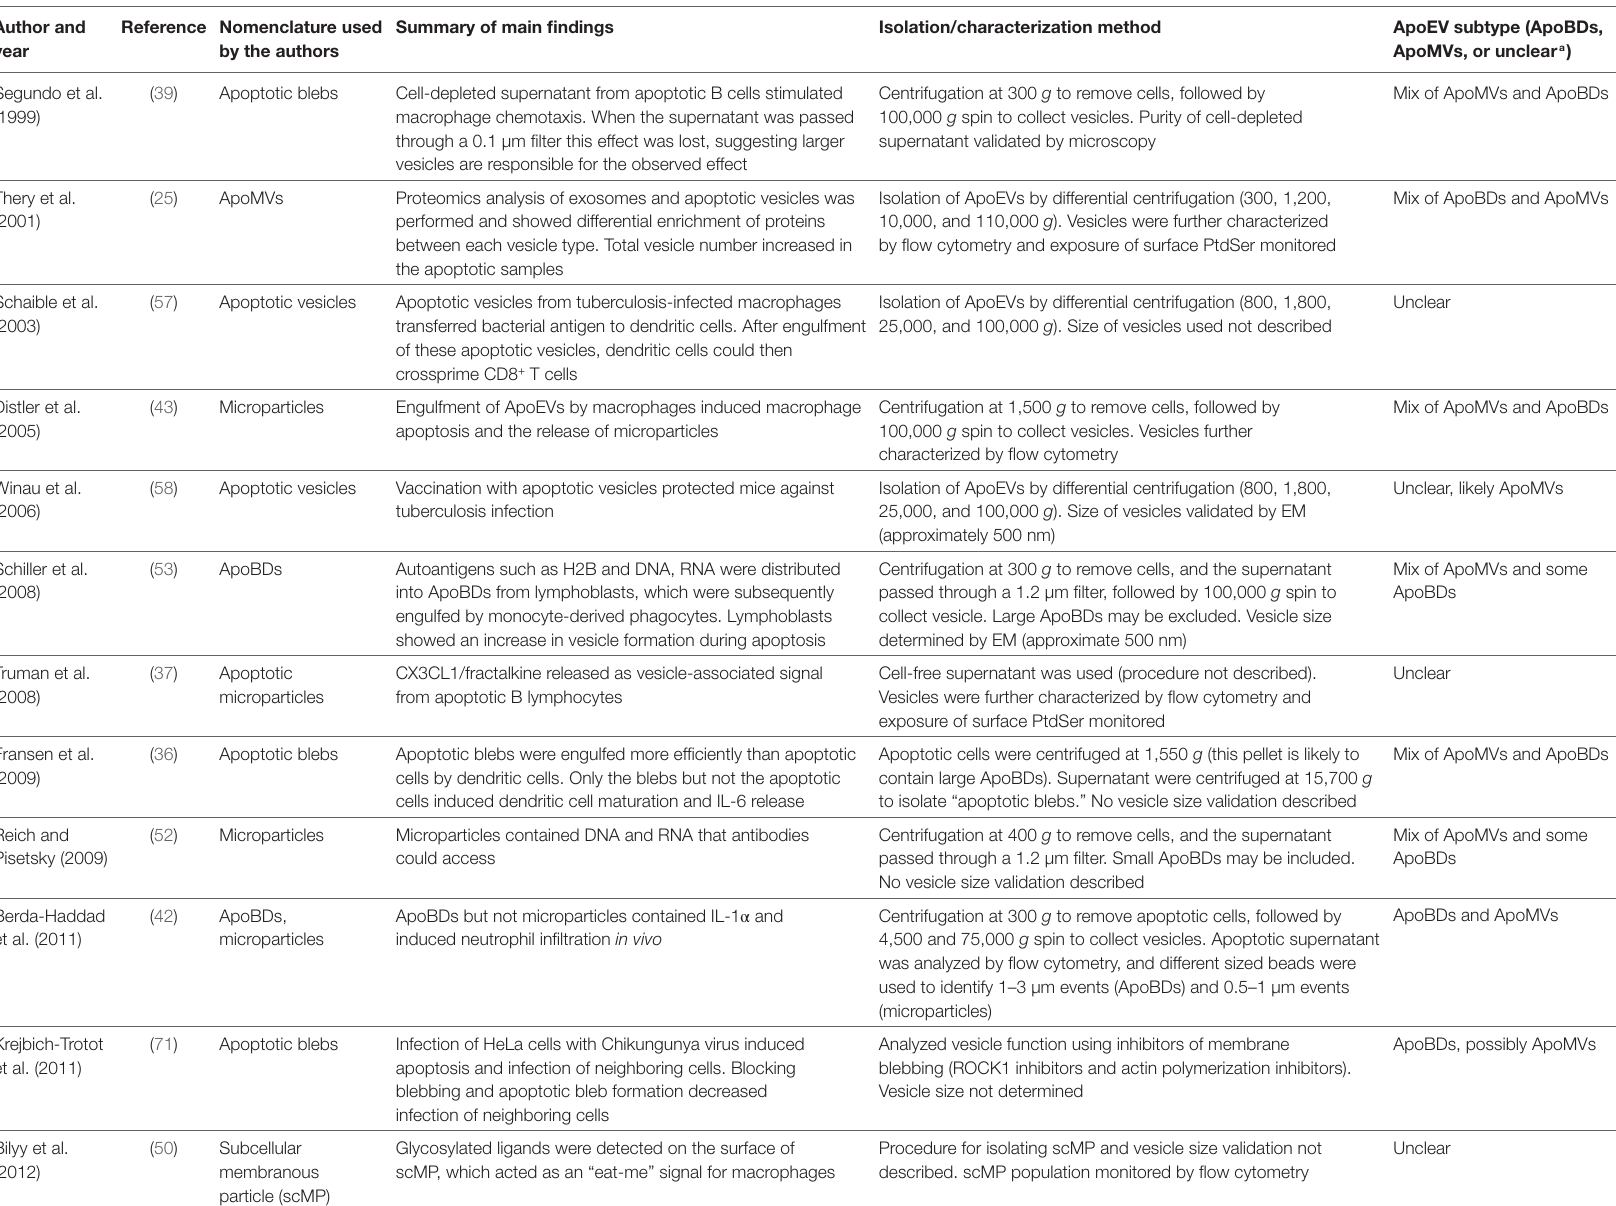
TABLe 1 | Variation in nomenclature and isolation/characterization methods in articles describing the immunomodulatory properties of